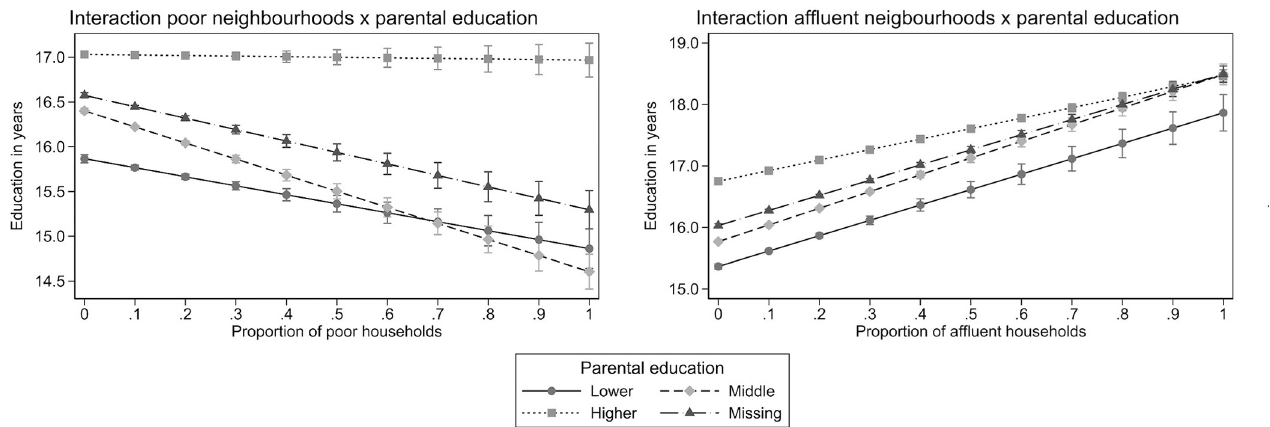
Fig 1. Interactions between the ratio of poor or affluent neighbours and the parental education.